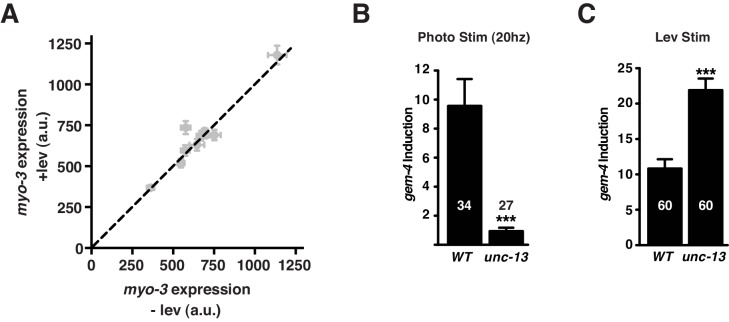
Supplemental data related to Figure 5.(A) myo-3 expression in body muscles was unaltered by Lev treatment. Pmyo-3::NLS-mCherry expression (using nuIs525) with and without Lev exposure is plotted for nine genotypes: crh-1, shn-1, 4 copies shn-1, shn-1/+, egl-19(nu496), unc-29, shn-1(ok1241), shn-1(tm488); egl-19(nu496), and unc-13. Equal expression +/- Lev is indicated by the dashed line. (B–C) A mutation that blocks synaptic transmission (unc-13) blocked photo-induced (B) but not Lev-induced (C) gem-4 expression. Error bars indicate SEM.